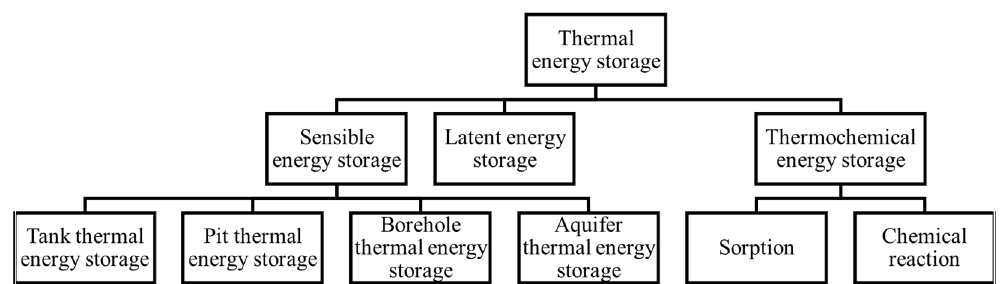
Figure 8. Classification of thermal energy storage.